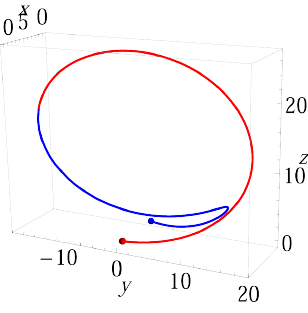
Figure 2. A stabilized trajectory corresponding to the initial conditions (10 , 0 . 6 , 0 . 5) (the red disk) and parameters a = 2 , b = 0 . 2 , c = 30 , k = 2 . 013; O (0 , 0 , 0) is a stable node(the blue disk).